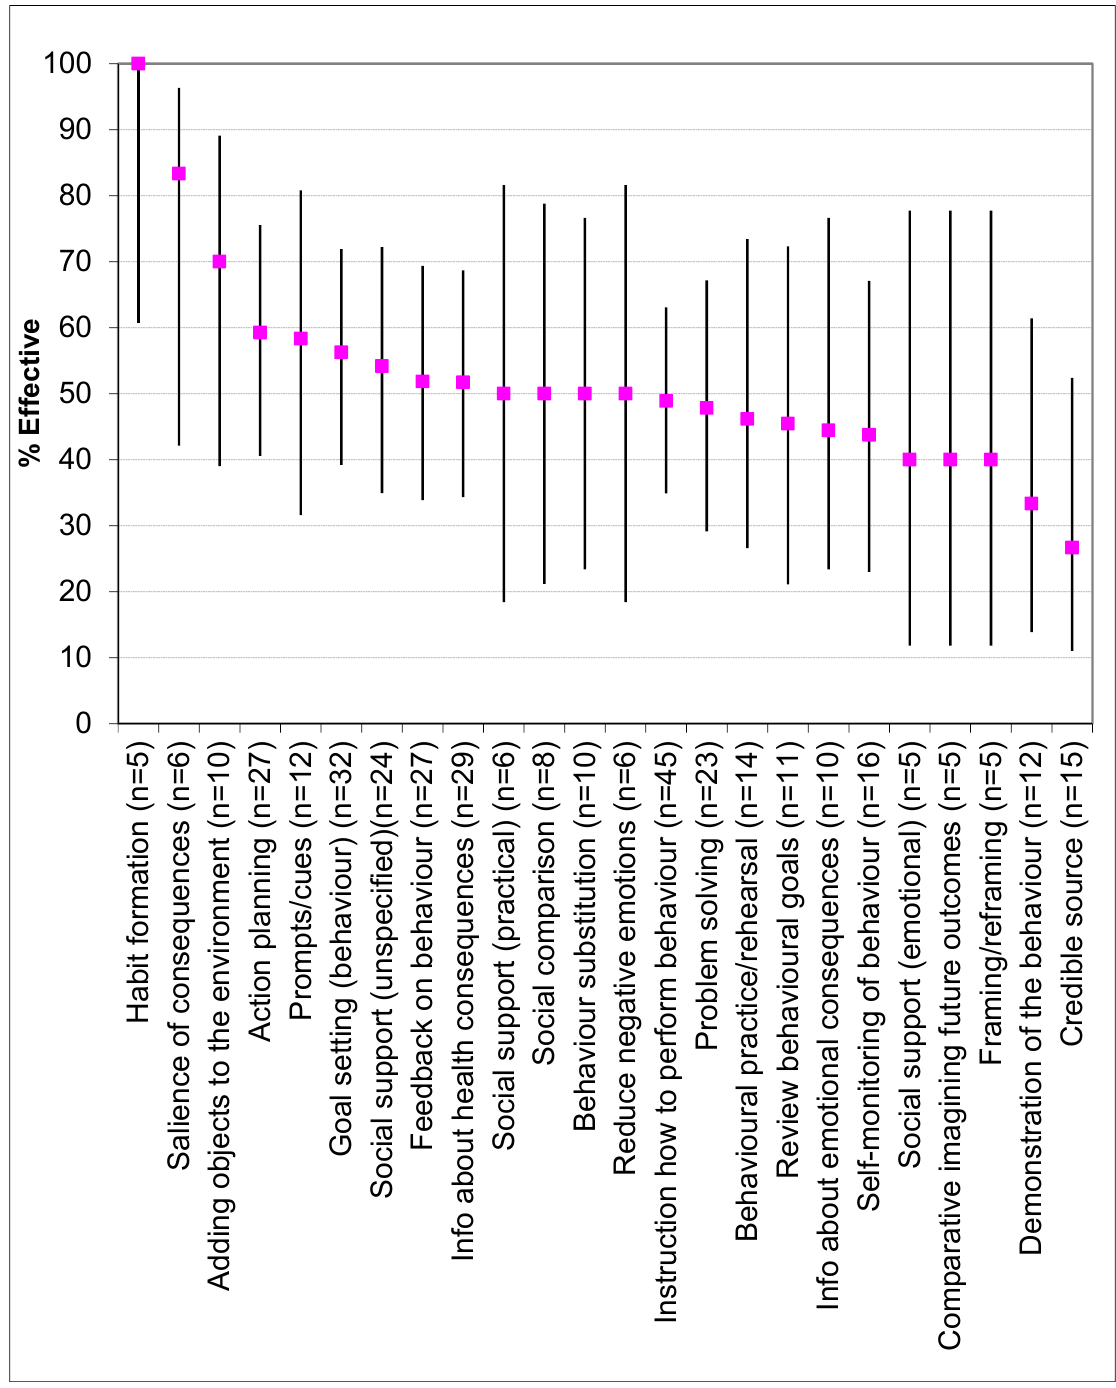
Figure 5. Percentage effectiveness of behaviour change techniques.